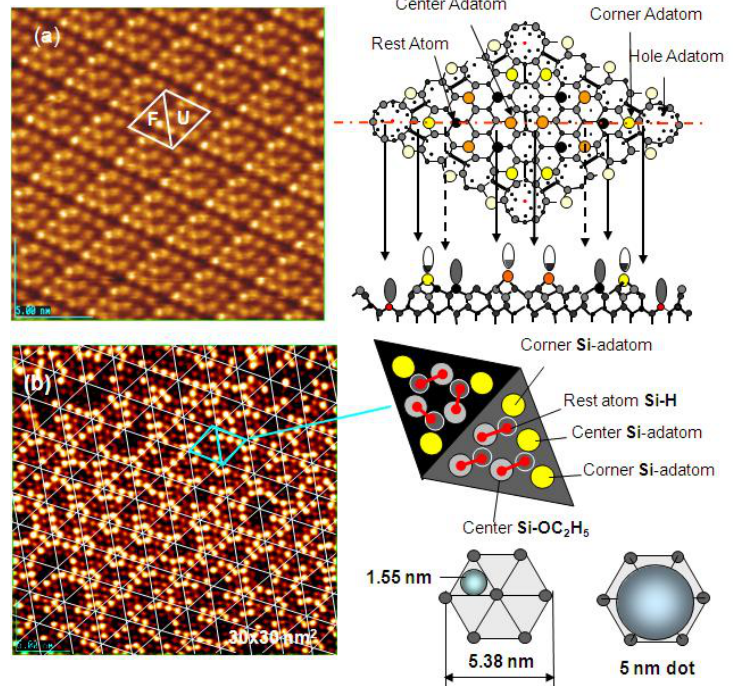
Figure 16. ( a ) A STM image of a clean Si(111)-7 × 7 surface. F and U are the faulted and unfaulted half-unit cells. A model of Si(111)-7 × 7 surface and the electron density of the dangling bonds; ( b ) A STM image of a Si(111)-7 × 7 surface saturated with C (  = 0.49). Dissociation of C H OH on (Si-adatom-Sirest atom) pair site is shown with bar 2 5 [59]. Estimation of the growth of dot in a half unit cell (1.5 nm) and in a hexagonal cell (5 nm) is